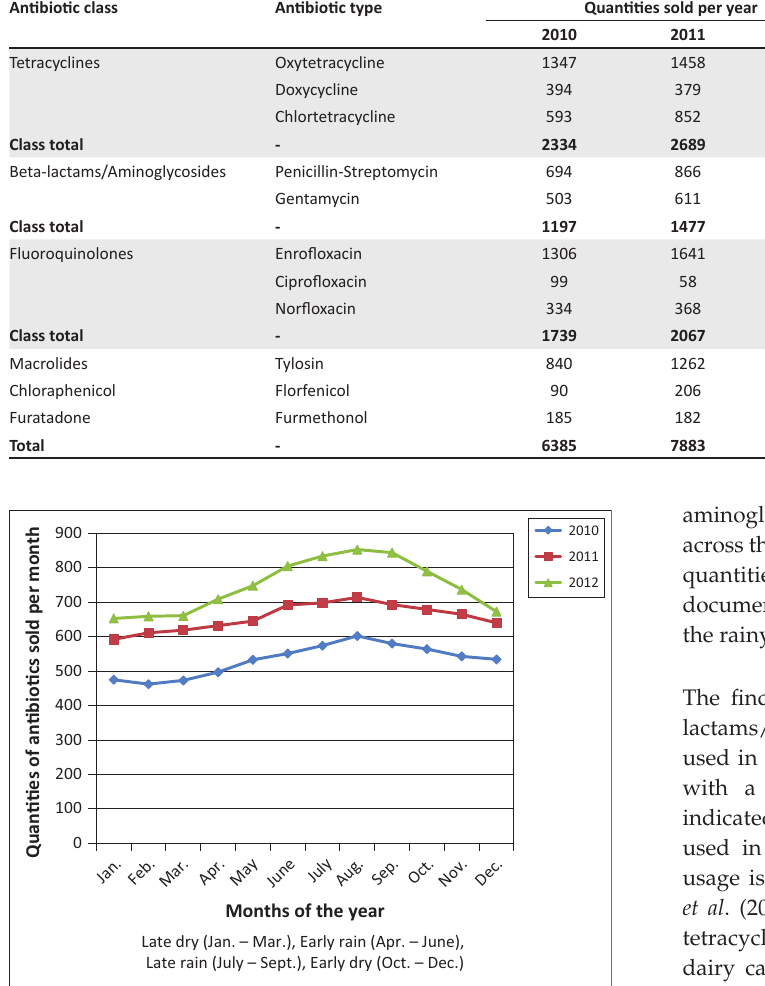
FIGURE 1: Distribution patterns of antibiotics consumption across the rainy and dry seasons (2010–2012).